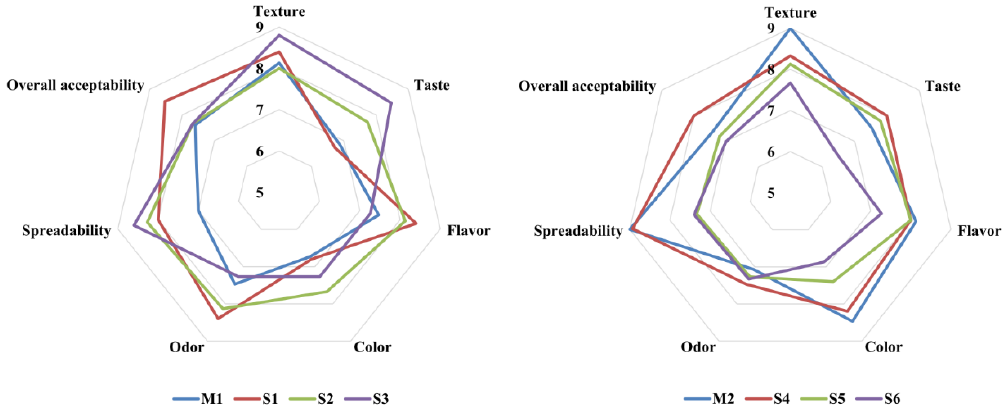
Figure 4. Sensory acceptability of walnuts butter samples.